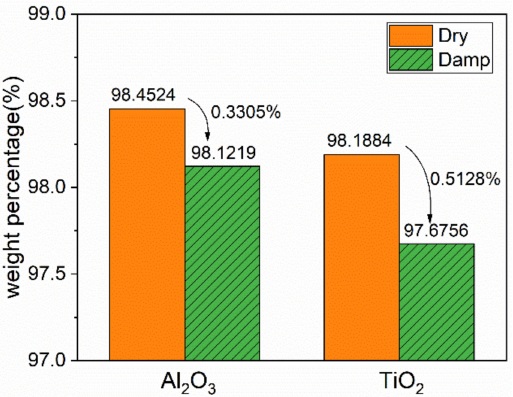
Figure 3. Remaining weight percentage of nanoparticles after TGA experiment.